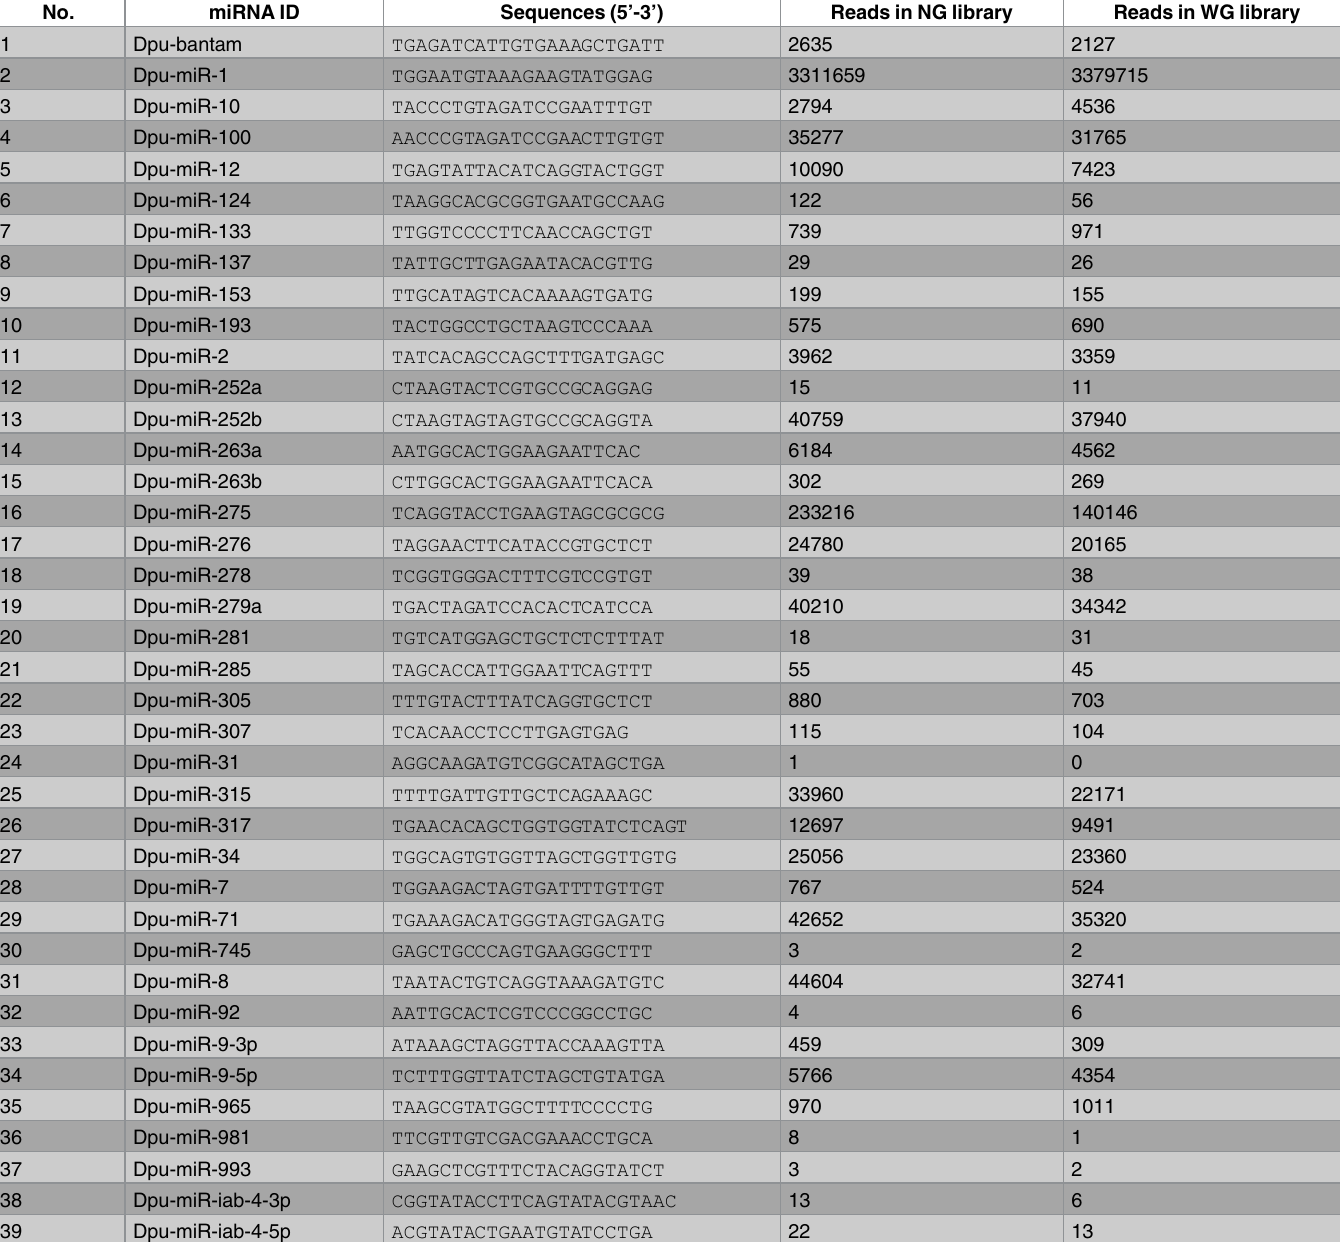
Table 1. Known miRNAs identified in NG and WG